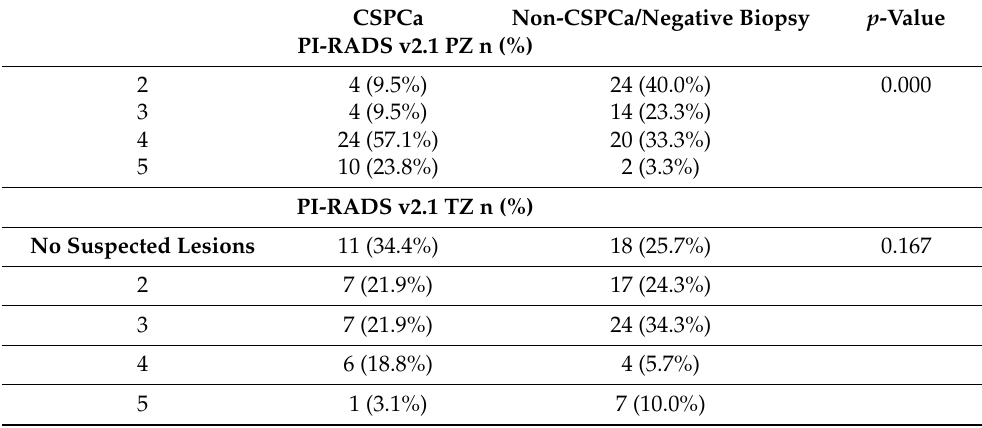
Table 2. PI-RADS v2.1 scores for the peripheral zone and the transitional zone.